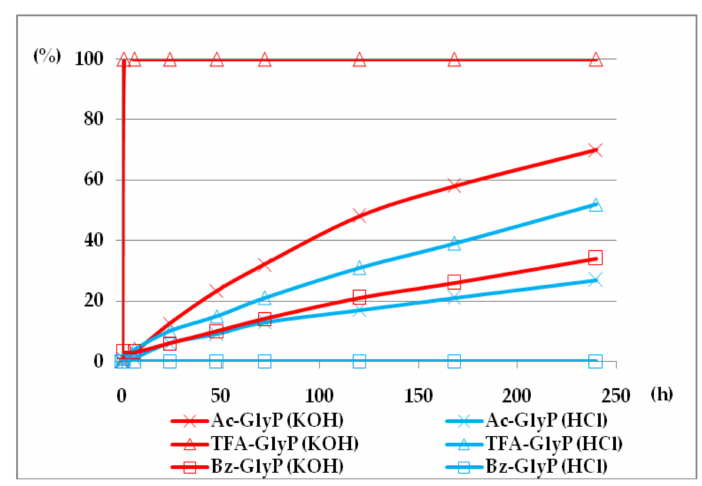
Figure 9. (AC)-Gly P (Ac-Gly P , TFA-Gly P , TFA-Gly P ) hydrolysis in aqueous solutions of 2M KOH and 2M HCl [DD (%) vs. time (h)].